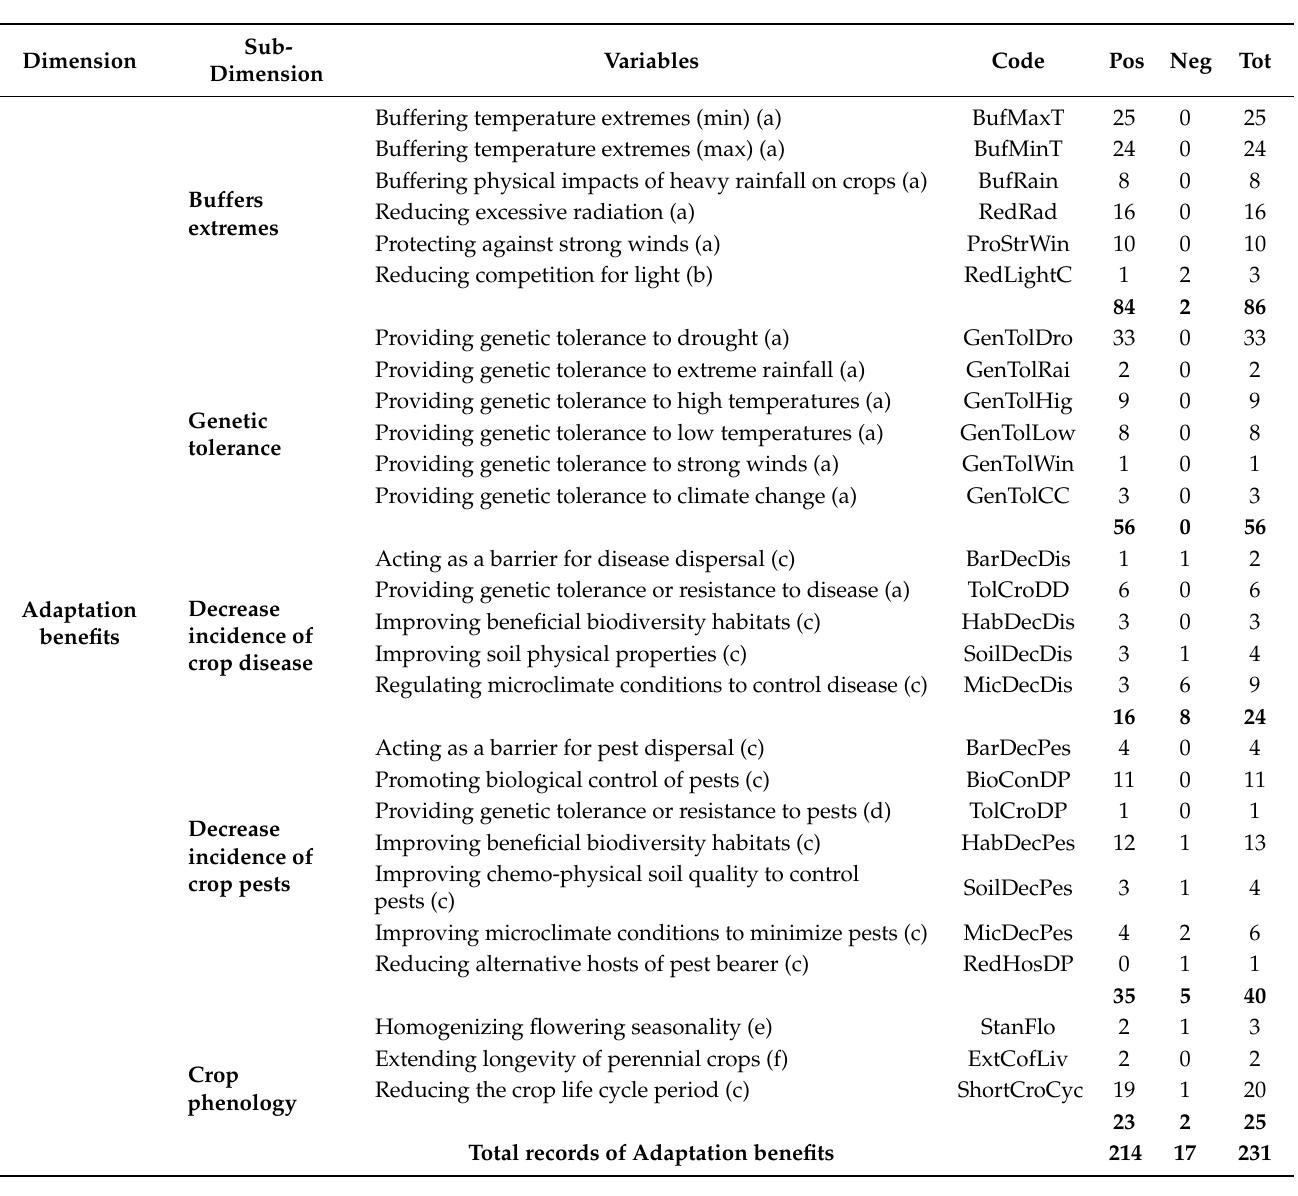
Table 2. List of the benefits and evidence, and the number of records registered regarding the positive (Pos) and negative (Neg) effects of coffee, maize and beans agricultural practices on smallholders in Latin America. In parentheses next to each variable description we included a reference to the literature* supporting the inclusion of benefit in the